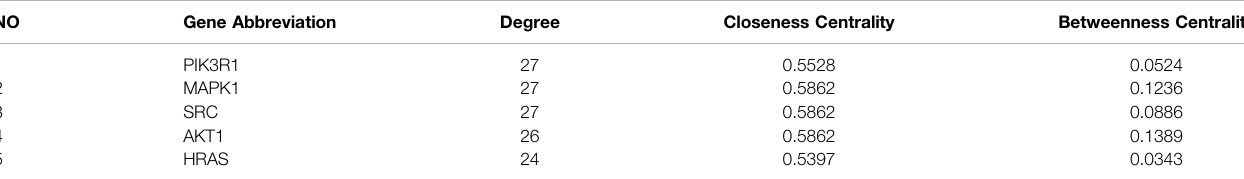
TABLE 1 | Top 5 targets with potentially critical roles in celastrol treatment of autoimmune hepatitis. NO Gene Abbreviation